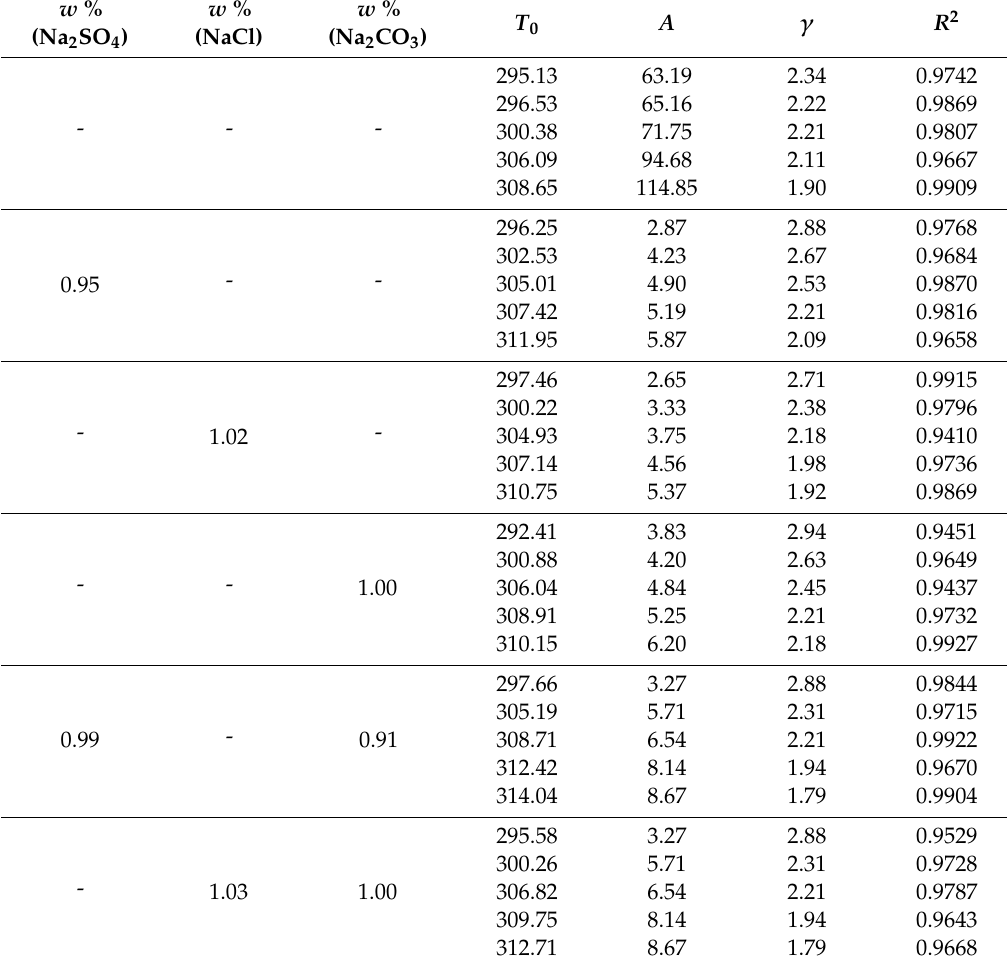
Table 2. Estimated kinetic parameters values using the classical 3D nucleation theory.